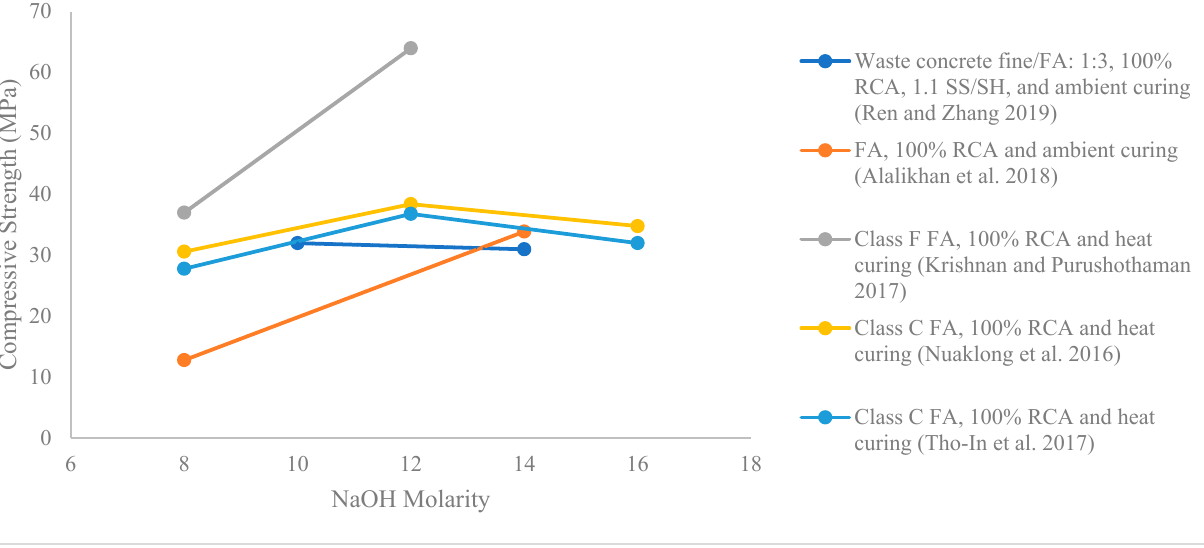
Figure 6. Relationship between NaOH molarity and CS [25,92,93,100,101]. Another factor is sodium silicate modulus. Wang, Bian, Li, Dai, Chen, Jiang, Zhang, Dong, Huang, and Ding [41] stated that the reduction of Na 2 SiO 3 modulus improves the strength of RCA-based GC but increases the brittleness. They prepared seven concrete mixtures with Na 2 SiO 3 moduli of 0.6, 0.9, 1.2, 1.5, 1.8, 2.1, and 2.4, while other parameters remained constant. The highest compressive strength was obtained when the modulus of Na 2 SiO 3 was 0.9. The reason is that decreasing the Na 2 SiO 3 modulus raises the amount of OH − and Na − , activating more alumina, calcium, and silicate ions. It will assist in forming